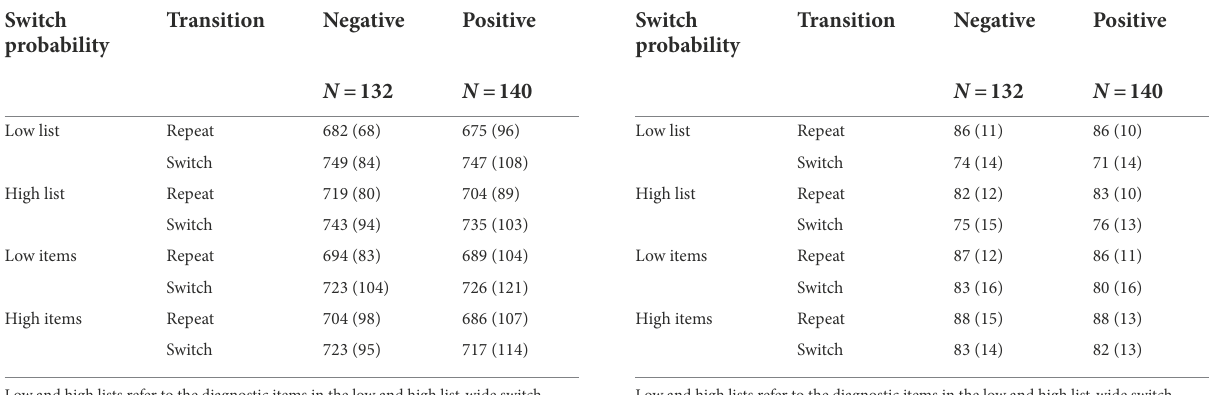
TABLE 2 Mean accuracy (%) with standard deviations in Experiment 1 as a function of background valence, switch probability, and